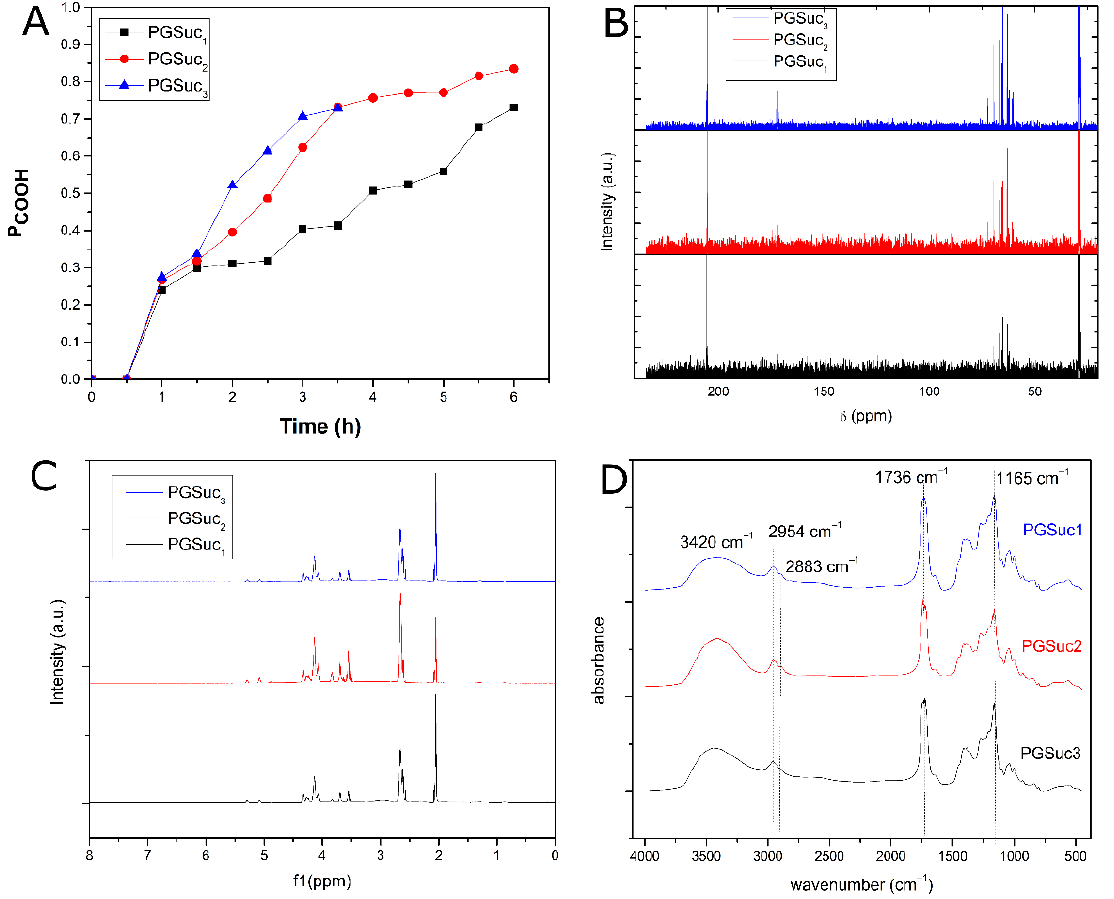
Figure 2. ( A ) Acid value determination, ( B ) 1 H-NMR spectra, ( C ) 13 C-NMR spectra and ( D ) FTIR spectra of the polymers.